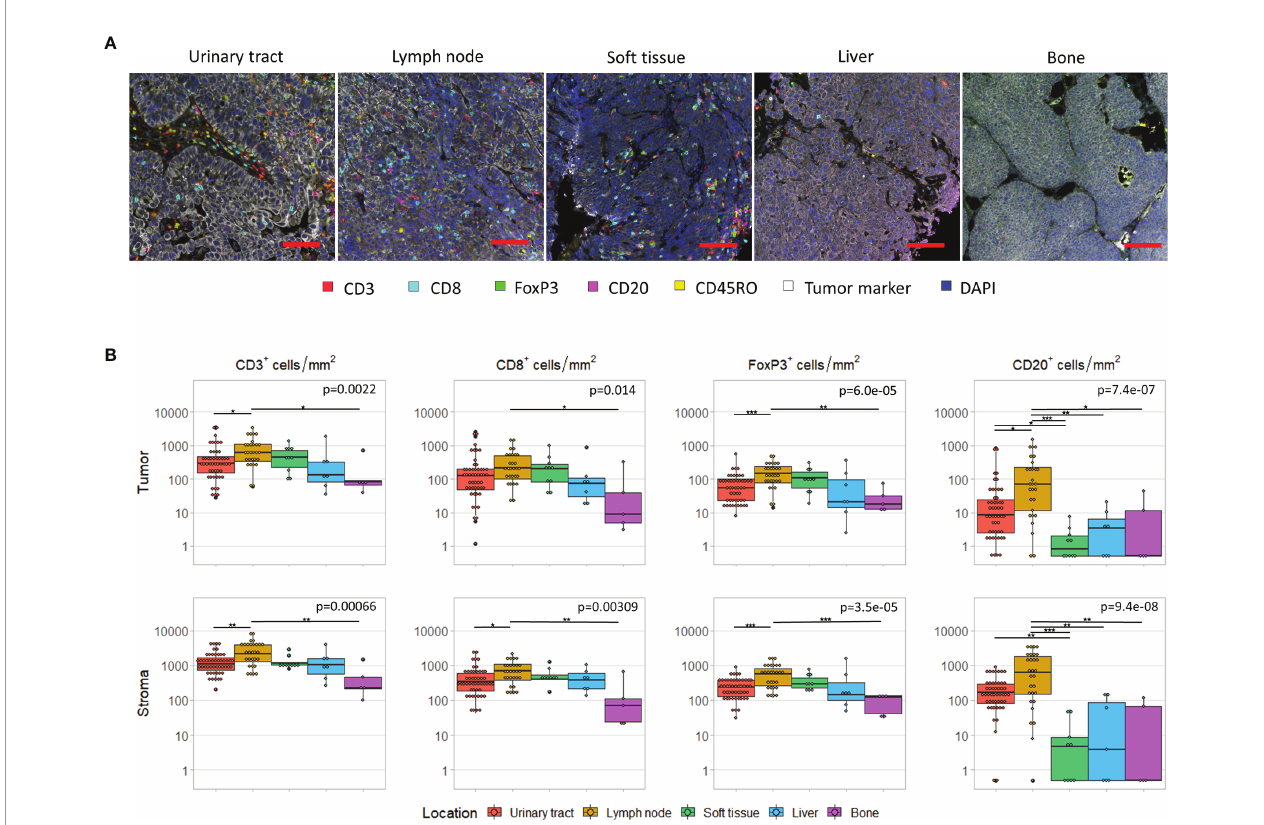
FIGURE 2 | Immune cell in fi ltrate per tissue site. (A) Multiplex immunohistochemistry images of the fi ve most frequent tissue sites. The scalebar represents a distance of 100 µm. (B) CD3 + , CD8 + , FoxP3 + and CD20+ cell density in the tumor (upper panel) and stroma compartment (lower panel) per tissue site. For all cell subsets, we observed signi fi cant differences between tissue sites, both in the stromal and tumoral compartments (Kruskal-Wallis test, p < 0.05). Black lines indicate signi fi cant differences between pairs (Dunn ’ s test, *p < 0.05, **p ≤ 0.01, ***p ≤ 0.001). In some patients, no CD20+ cells were present. To enable visualization of cell densities on a log scale, the CD20+ densities of these patients was replaced by 0.5 cells/mm2 (~lowest value in this